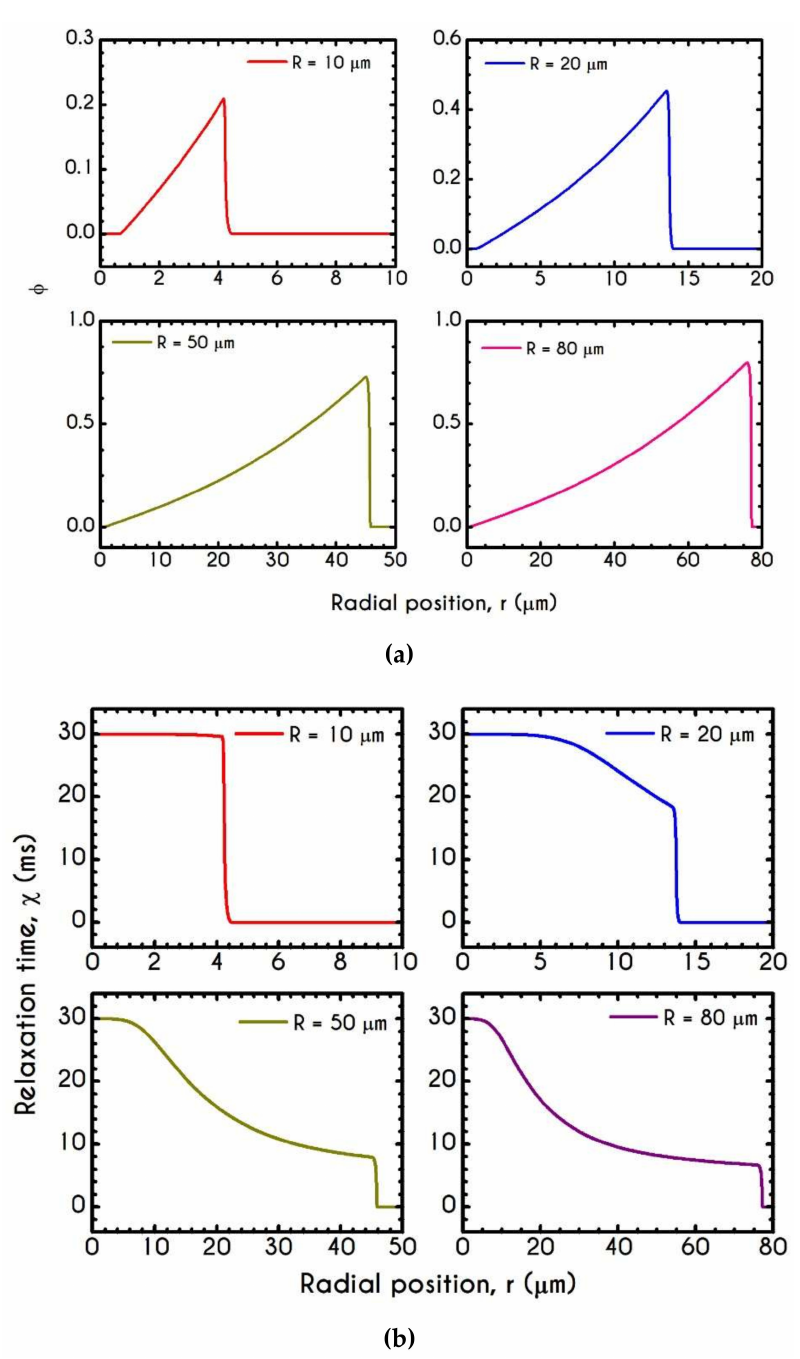
Figure 10. Distribution of ( a ) Parameter ϕ and ( b ) Relaxation time χ along the radial position r for tube radius of 10 µ m, 20 µ m, 50 µ m, and 80 µ m for J = 10 4 Pa/m and H c =